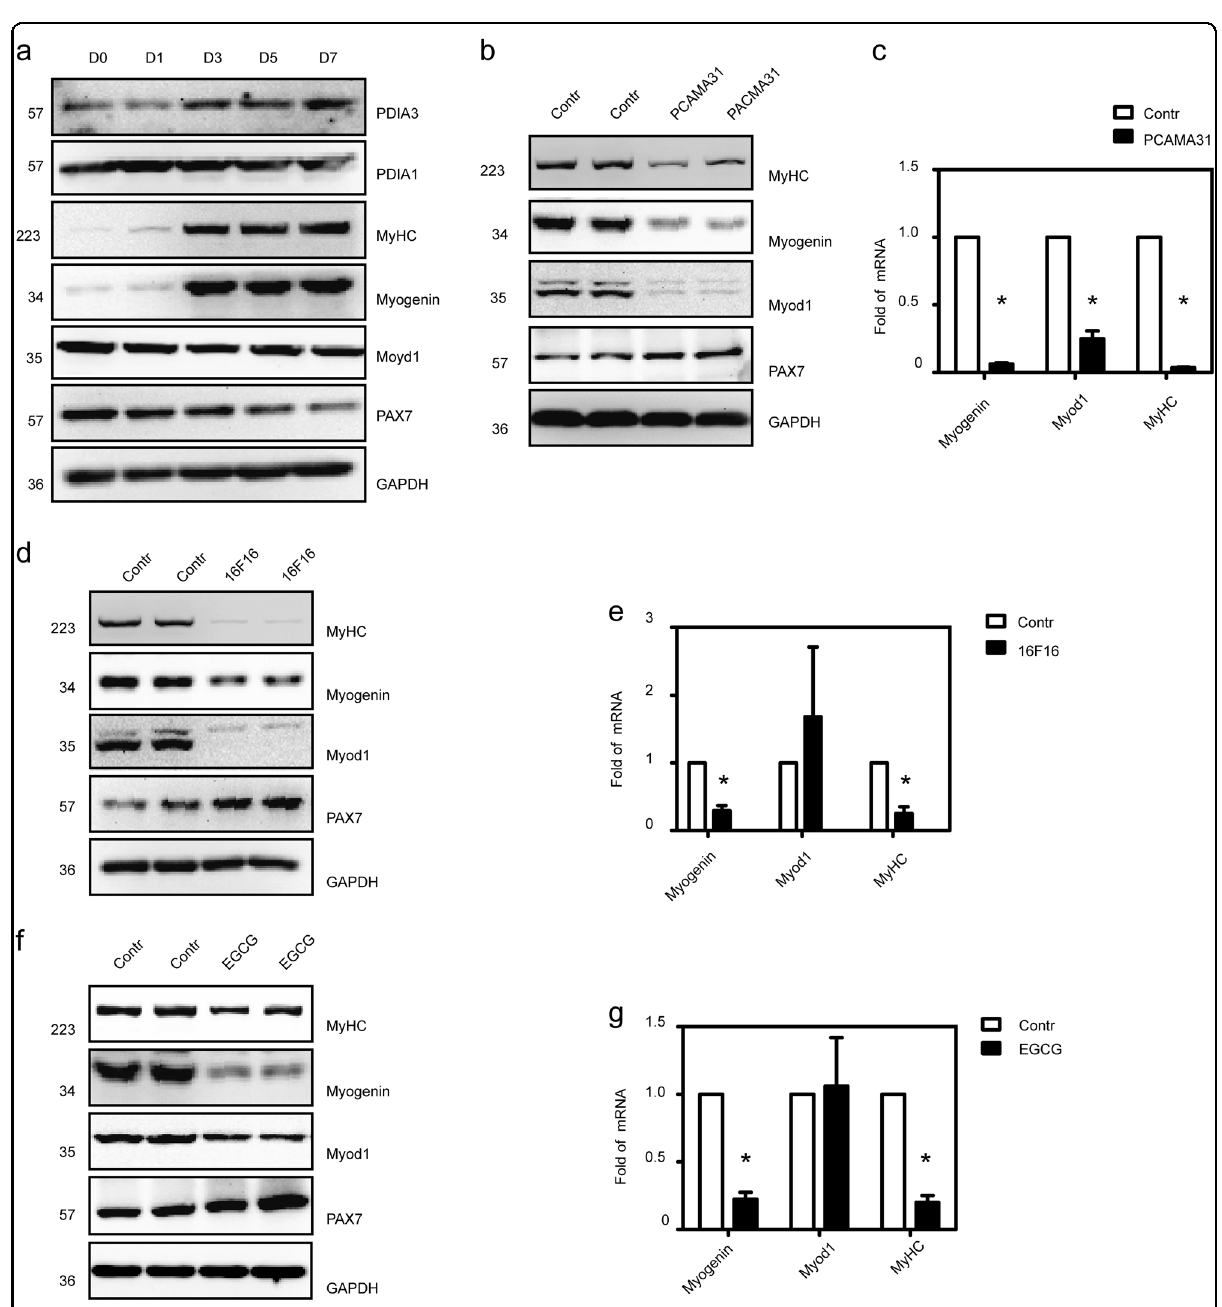
Fig. 4 The role of PDIA3 in myoblast differentiation. a C2C12 myoblasts were induced to differentiate for 1, 3, 5, and 7 days. The expression of PDIA1, PDIA3, Pax7, myogenin, Myod1, and MyHC were detected by immunoblotting ( n = 4). b C2C12 myoblasts were differentiated for 48 h and treated with PCAMA31. After 24 h, the expression of myogenin, Myod1, and MyHC were measured by immunoblotting ( n = 4). c The levels of myogenin, Myod1, and MyHC mRNA in C2C12 cells treated with PCAMA31 were detected by q-PCR (* P < 0.05 vs. Control; n = 4). d C2C12 myoblasts were induced to differentiate for 48 h and treated with 16F16. After 24 h, the expression of myogenin, Myod1, and MyHC were assessed by immunoblotting ( n = 4). e The levels of myogenin, Myod1, and MyHC mRNA in C2C12 cells treated with 16F16 were detected by q-PCR (* P < 0.05 vs. Control; n = 4). f C2C12 myoblasts were induced to differentiate for 48 h and treated with EGCG. After 24 h, the expression of myogenin, Myod1, and MyHC were tested by immunoblotting ( n = 4). g The levels of myogenin, Myod1, and MyHC mRNA in C2C12 cells treated with EGCG were detected by q-PCR (* P < 0.05 vs. Control; n =